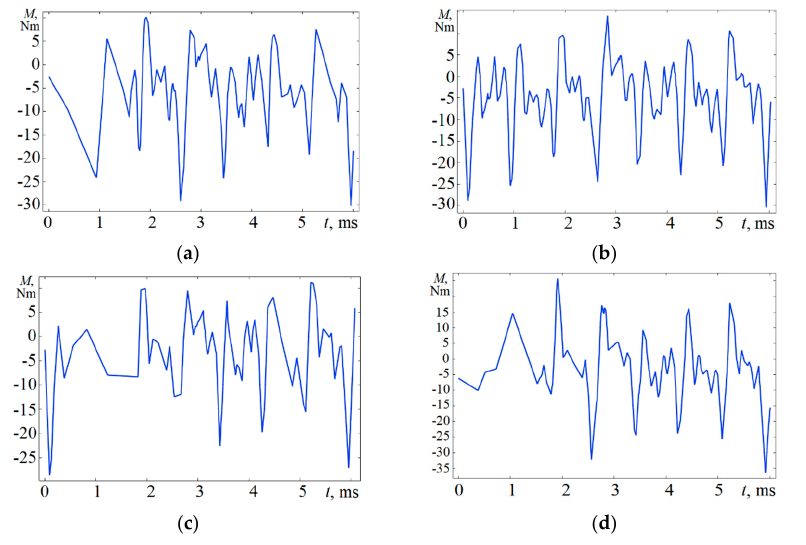
Figure 10. Electromagnetic torque of investigated motor with supply voltage imbalance: ( a ) I A = I B = I C ; ( b ) I A = 1.1· I B = 0.9· I C ; ( c ) I A = 1.4 ·I B = 0.8· I C ; ( d ) I g 3 = 15.4 A , I g 5 = 7.7 A , I A = 1.4 ·I B = 0.8 ·I C